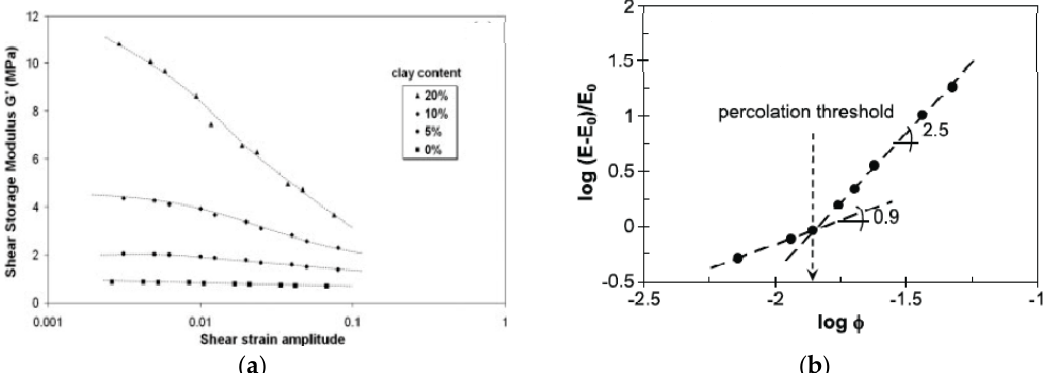
Figure 6. ( a ): Dynamic storage modulus plotted against strain amplitude for NR/OC samples, Reproduced with permission from [53]. Copyright Wiley, 2007; ( b ): Double logarithmic plot of the excess modulus (E − E 0 ) with respect to the modulus of the unfilled vulcanizate E 0 against the filler volume fraction, Reproduced with permission from [54]. Copyright Elsevier, 2009.